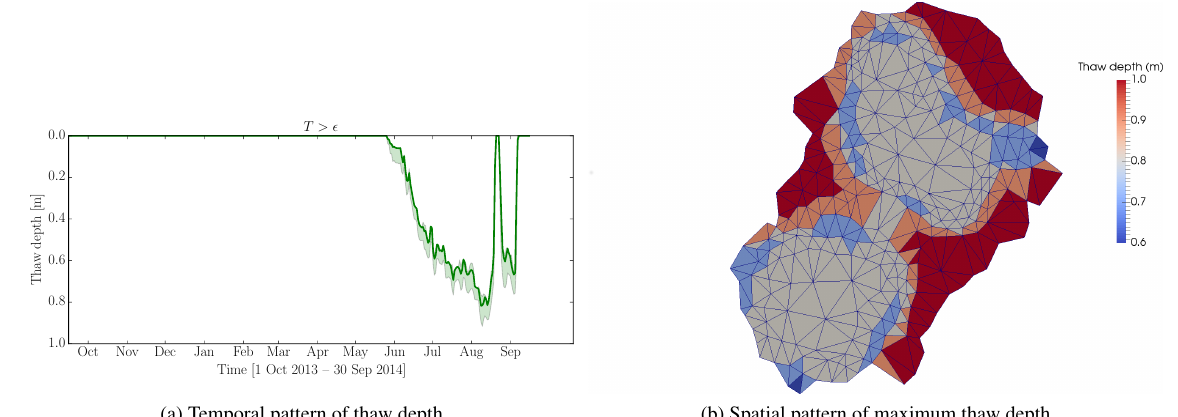
Figure 14. Temporal (left panels) patterns of simulated thaw depths (defined as thickness of soil layers above 0 ◦ C) and spatial pattern of maximum thaw depth (right panels) at Site B. The bold line represents the mean thaw depth across the site, while the shaded curve represents standard deviation.